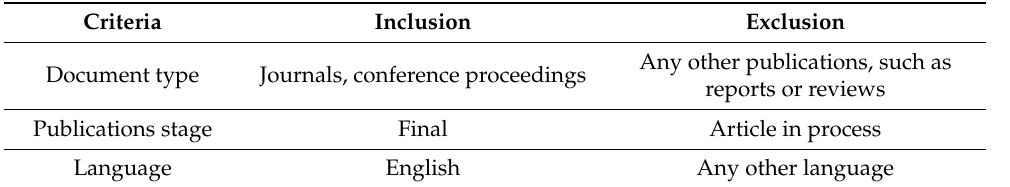
Table 2. Criteria of inclusion and exclusion.